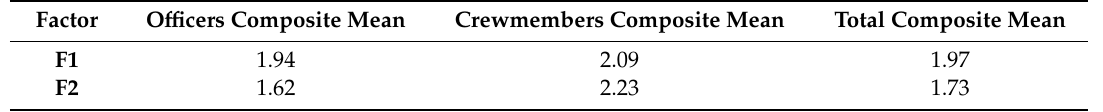
Table 5. Composite means of extracted